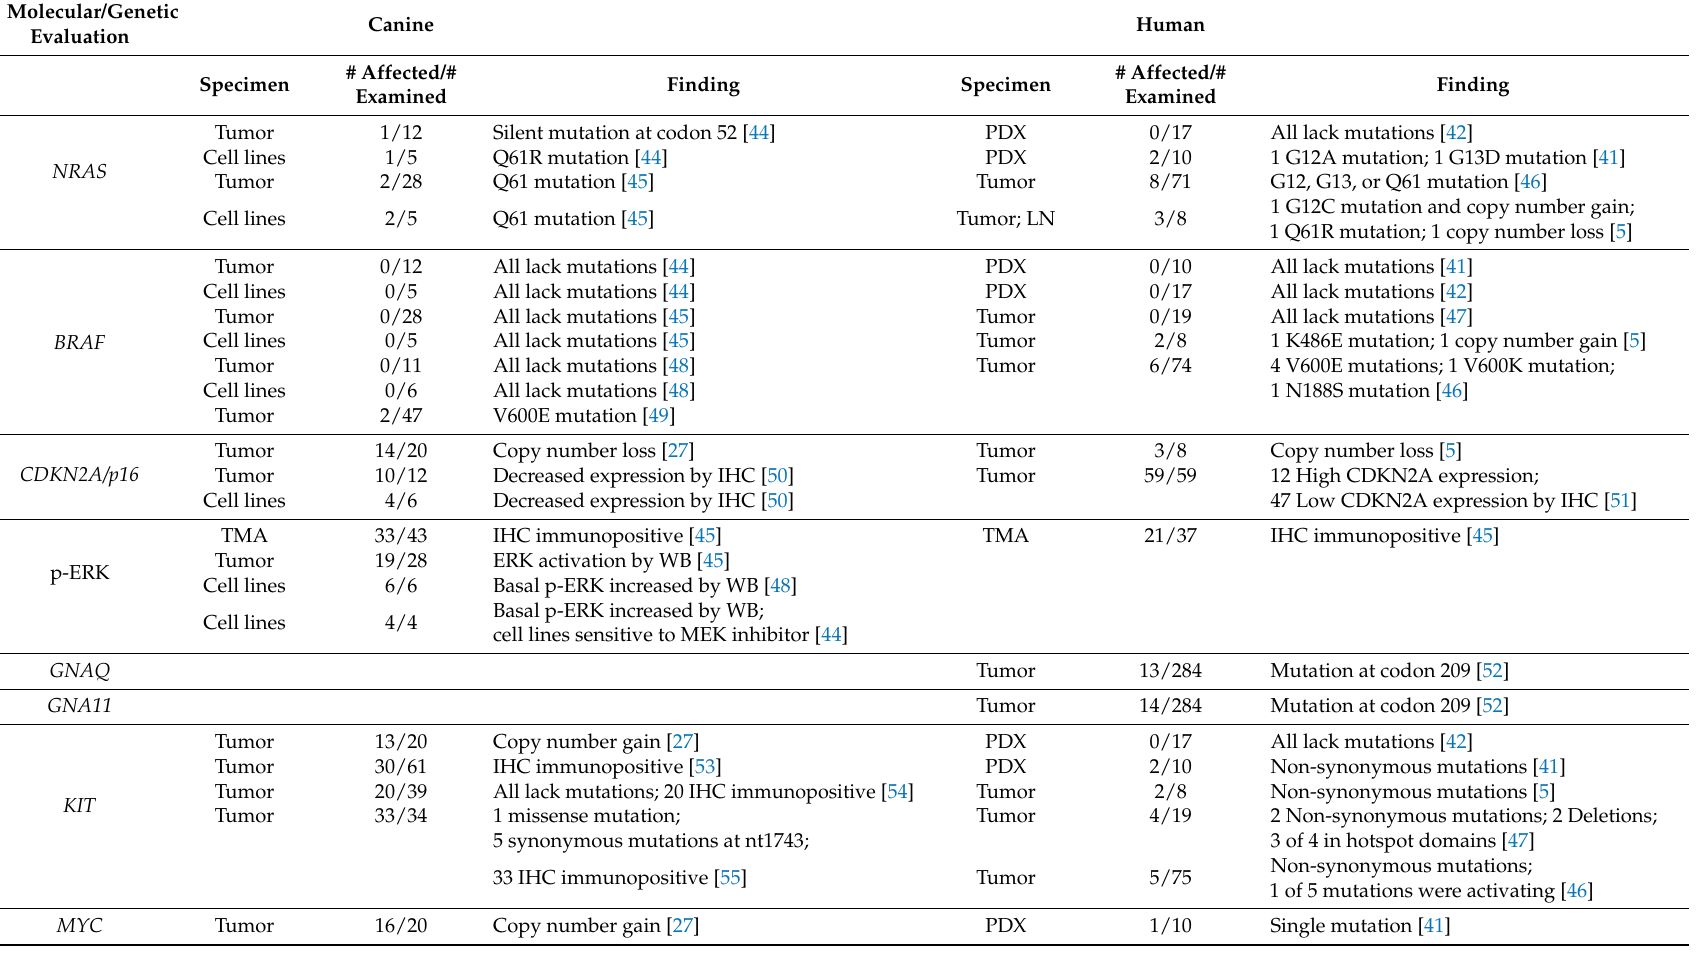
Table 1. Summary of molecular/genetic findings in canine and human mucosal